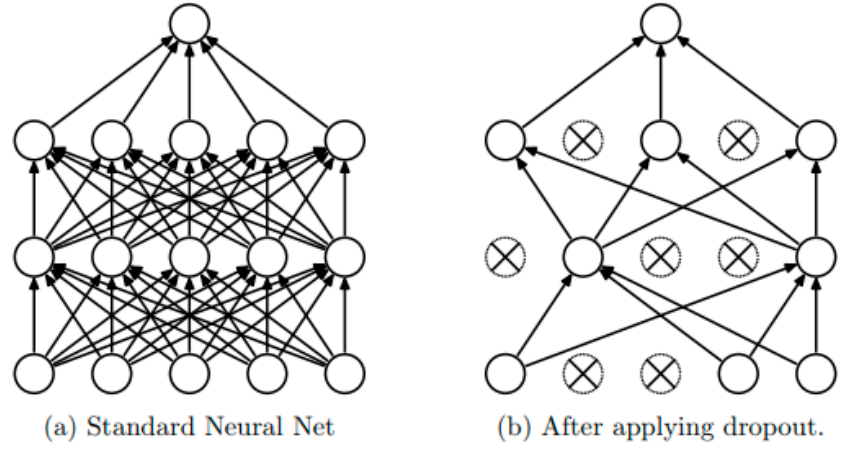
Figure 6. Neural network model of dropout.